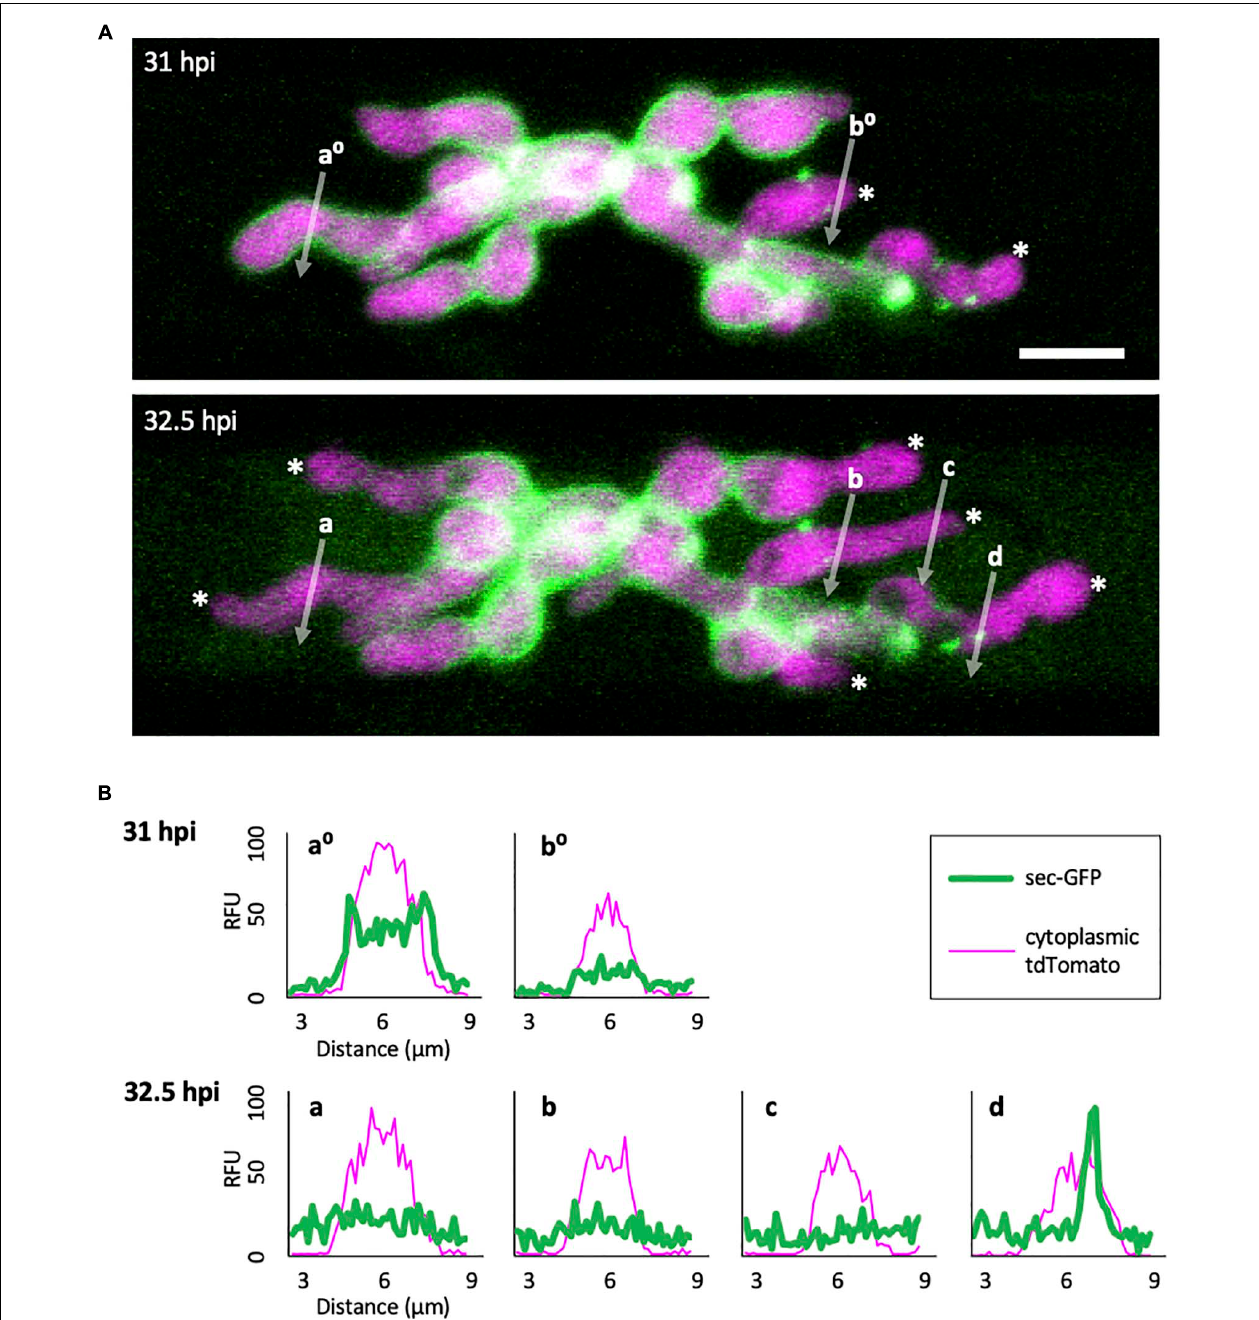
FIGURE 3 | Sec-GFP localization changes during the process of EIHM disruption. (A) M. oryzae CKF1996 expressing sec-GFP (green) and cytoplasmic tdTomato (magenta) invading a rice cell. Shown are merged fluorescence projections of informative focal planes from the same infection site at 31 (top) and 32.5 hpi (bottom). At 31 hpi sec-GFP localized in the host cytoplasm (not shown in the field of view) and outlined most IH (IH without asterisks and linescan a 0 ). Two IH had lost sec-GFP outlining (white asterisks and linescan b 0 ). The same infection 1.5 h later had increased sec-GFP accumulation in the host cell (now visible in the field of view) and loss of sec-GFP outline from additional IH (increase from 2 to 6 white asterisks). White letters and arrows denote the locations used to generate the fluorescence intensity linescans shown in panel (B) . Bar = 10 µ m. (B) Linescans showing the relative fluorescence intensities (RFU; y-axis, distance in µ m; x-axes) of sec-GFP (green) and cytoplasmic tdTomato (magenta) from panel (A), highlighting features of sec-GFP fluorescence localization changes during the process of EIHM disruption. Linescans at 31 hpi show an IH with a sec-GFP outline (a 0 ) and an IH without a sec-GFP outline (b 0 ). Linescans generated from the same locations at 32.5 hpi show new loss of sec-GFP outline (a) and maintained absence of sec-GFP outlining after initial loss (b). Additional linescans show: new IH growth after sec-GFP outline loss without accumulation of new sec-GFP outline (c), and a sec-GFP puncta associated with outline loss (d). Note that linescans generated at 32.5 hpi clearly show sec-GFP fluorescence spilled into the rice cell lumen (green fluorescence not associated with IH).